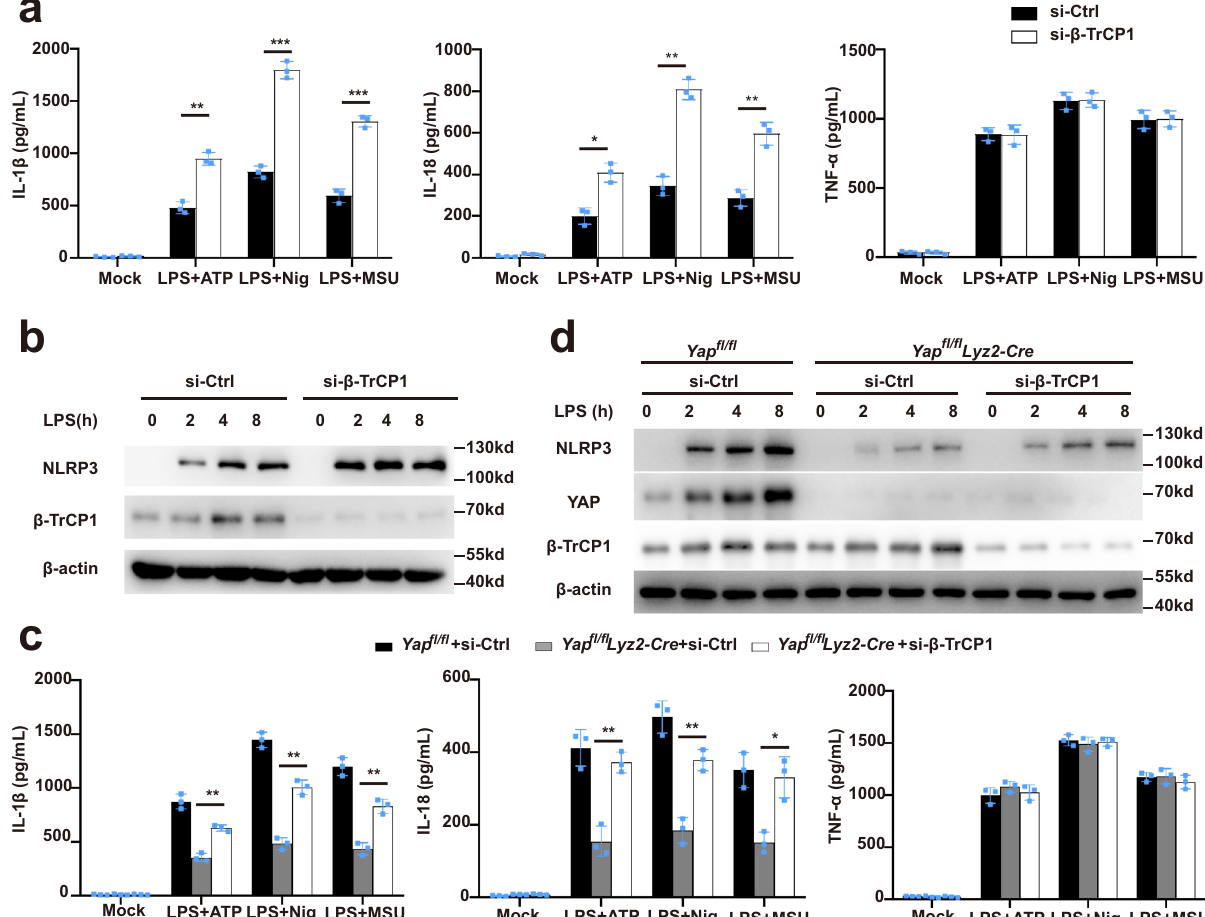
Fig. 6 β -TrCP1 inhibits NLRP3 in fl ammasome activation. a ELISA of IL-1 β , IL-18, and TNF- α in supernatants from mouse peritoneal macrophages silenced of β -TrCP1, treated with indicated stimuli (mean ± SD, two-way ANOVA with Bonferroni test, β -TrCP1 siRNA vs. Ctrl siRNA, left panel: ** P = 0.0024, *** P = 0.0006, *** P = 0.0006 in sequence; middle panel: * P = 0.0169, ** P = 0.0011, ** P = 0.0081 in sequence; n = 3 independent experiments). b Immunoblot analysis of extracts from mouse peritoneal macrophages silenced of β -TrCP1, then stimulated for indicated times with LPS. c ELISA of IL-1 β , IL-18, and TNF- α in supernatants from Yap fl / fl lyz2-Cre or Yap fl / fl peritoneal macrophages silenced of β -TrCP1, treated with indicated stimuli (mean ± SD, two-way ANOVA with Bonferroni test, Yap fl / fl lyz2-Cre + β -TrCP1 siRNA vs. Yap fl / fl lyz2-Cre + Ctrl siRNA, left panel: ** P = 0.0023, ** P = 0.0018, ** P = 0.0047 in sequence; middle panel: ** P = 0.0084, ** P = 0.0066, * P = 0.0498 in sequence; n = 3 independent experiments). d Immunoblot analysis